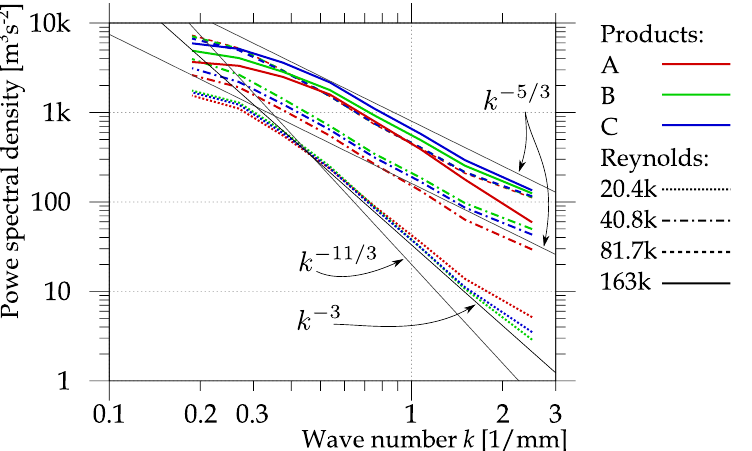
Figure 16. Spatial spectra of turbulent kinetic energy. The different products are distinguished by color, the Reynolds number by the line style; the angle of attack is zero in all cases. Thin lines represent scalings k − 5/3 , k − 3 , and k − 11/3